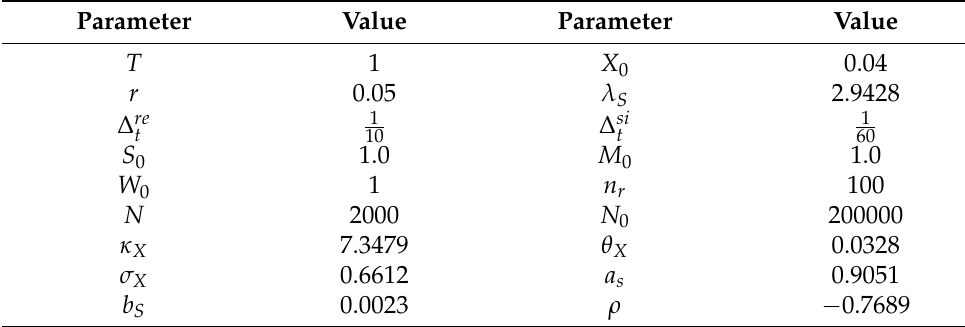
Table 2. Parameter values for 4/2